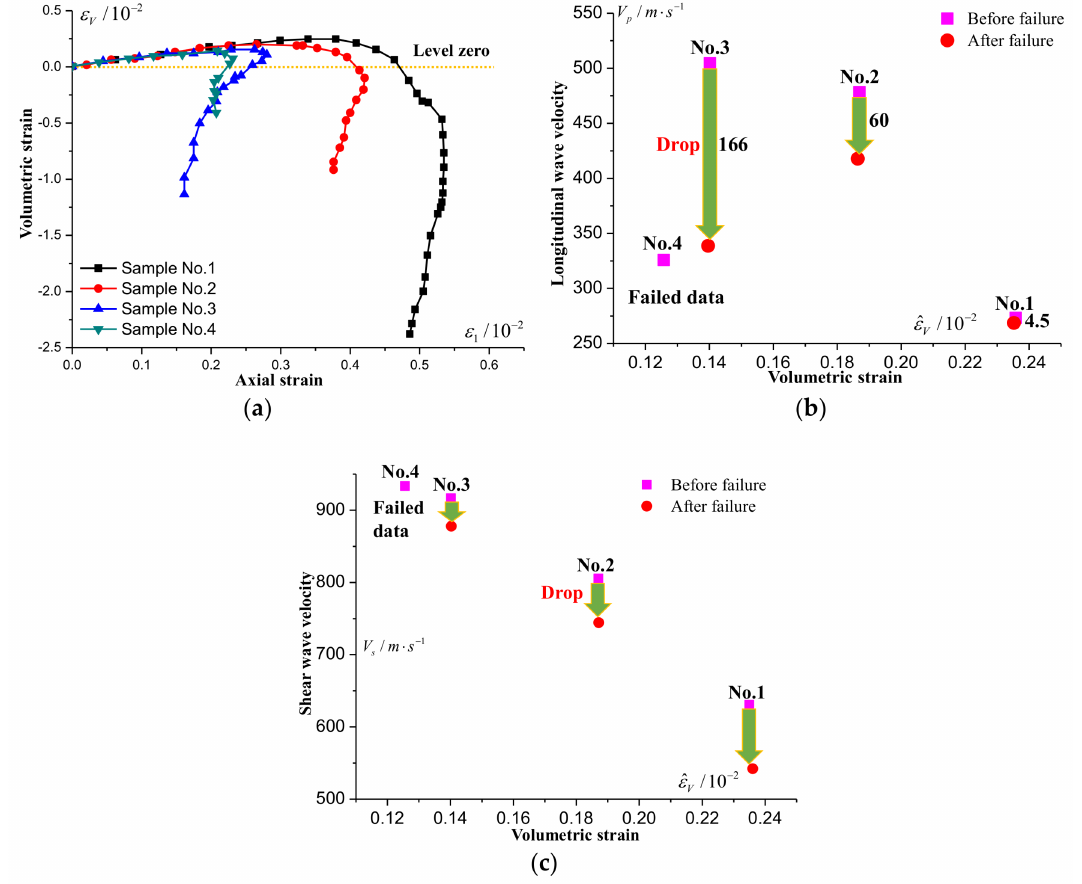
Figure 3. Dilatancy and integrity evaluation. ( a ) Relationship between axial strain and volumetric strain. ( b ) Longitudinal wave velocity. ( c ) Shear wave